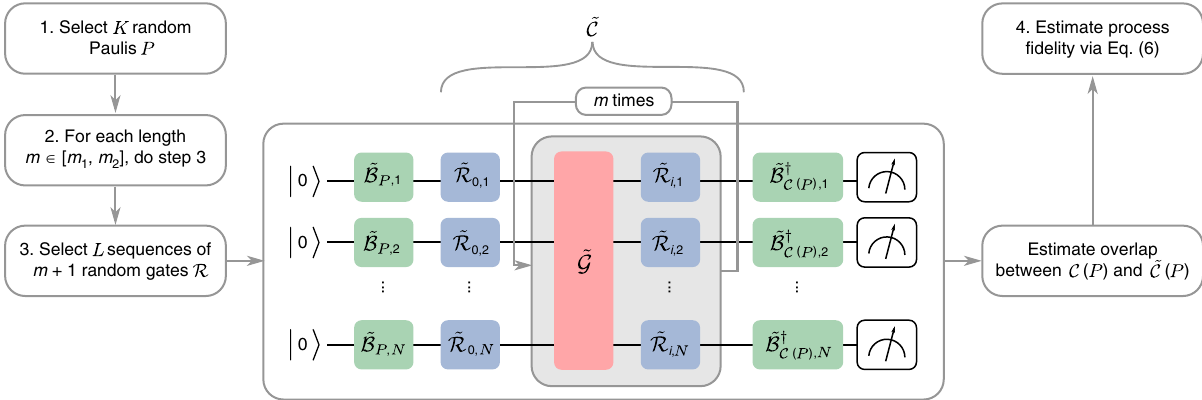
Fig. 1 Schematic circuit implementation of the experimental cycle benchmarking protocol. The protocol can be subdivided into three parts, depicted by the different colors. The green gates ~ B describe basis changing operations for the state preparation and the measurement (SPAM) procedure. The red gates ~ G are the noisy implementations of some gate of interest (in this work, the global Mølmer – Sørensen gate acting on all qubits). The blue gates are random Pauli cycles that are introduced to create an effective Pauli channel per application of the gate of interest, where ~ R i ; j denotes the j th tensor factor of the i th gate. Creating an effective Pauli channel per application enables errors to be systematically ampli fi ed under m -fold iterations for more precise and SPAM- free estimation of the errors in the interleaved red gates ~ G . The blue and the red gates together form the random circuit ~ C . The sequence of local operations before the fi rst and last rounds of random Pauli cycles are identi fi ed as conceptually distinct but were compiled into the initial and fi nal round of local gates in the experiment. The experimental parameters K ; m , and L of this work and the exact de fi nitions of ~ B and ~ R are given in Supplementary Note